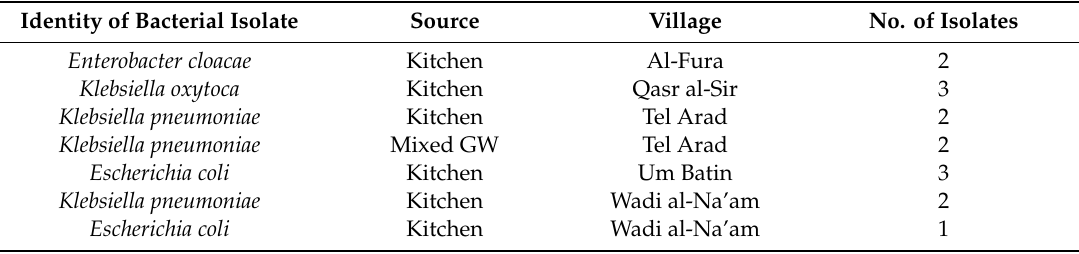
Figure 1. Resistance patterns observed in presumptive ESBL isolates (n = 81) obtained from GW of Bedouin villages against clinically relevant antimicrobials. Data shows percentage susceptible, intermediate, and resistant to clinically relevant antimicrobials among 81 isolates recovered on CHROMagar ESBL media. Table 3. Extended-spectrum β -lactamase (ESBL) producers identified from greywater samples. Data presented in table shows total numbers of ESBL-producers identified from initial 81 bacterial isolates obtained by pre-selection on ESBL CHROMagar ®